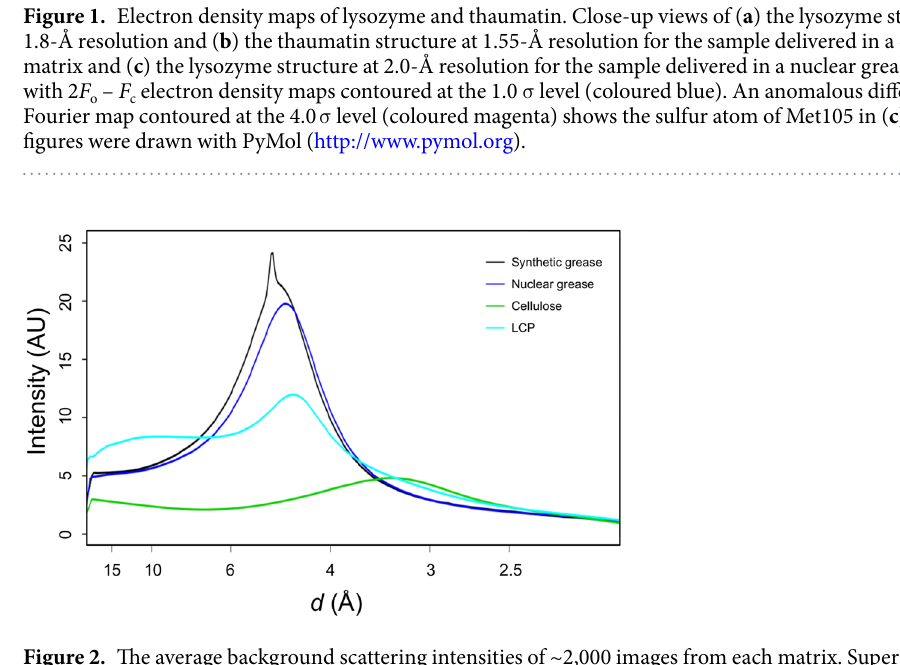
Figure 2. The average background scattering intensities of ~2,000 images from each matrix. Super Lube synthetic grease, Super Lube nuclear grease, 16% ( w/v ) hydroxyethyl cellulose solution and LCP are depicted by the black, blue, green and cyan lines,